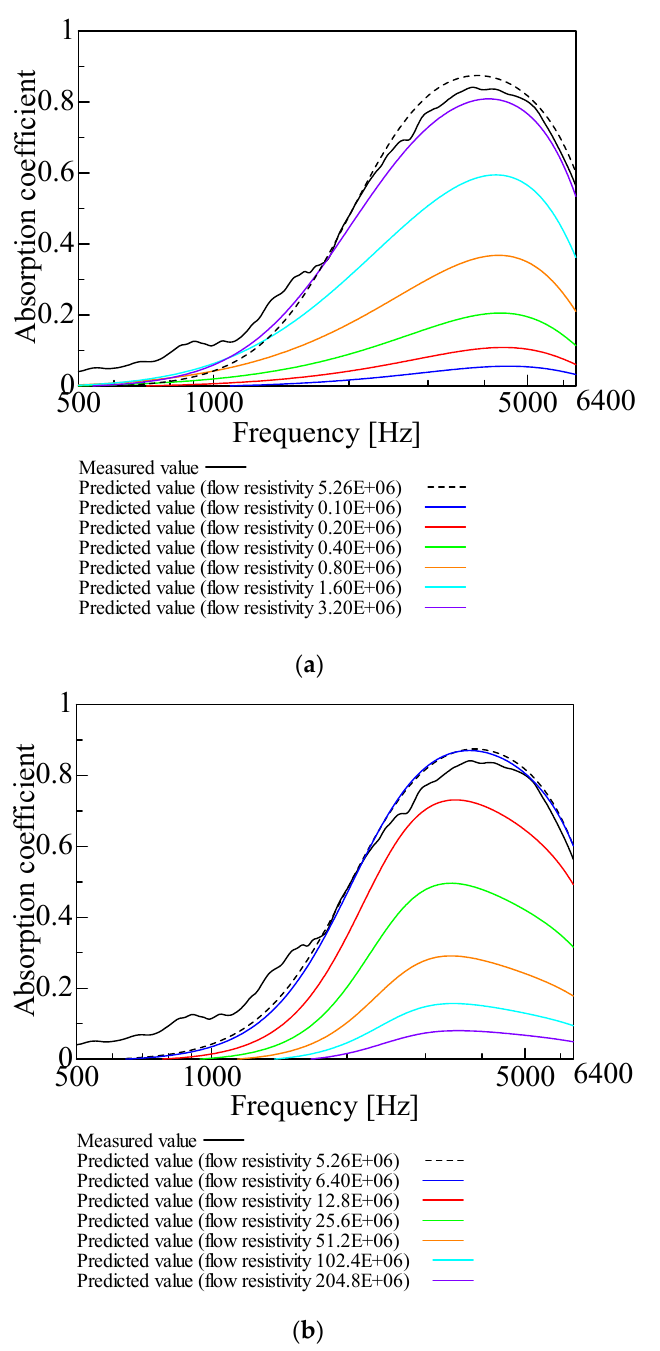
Figure 3. Variation of predicted value due to variation of flow resistivity: ( a ) flow resistivity 0.10 × 10 6 –3.20 × 10 6 and 5.26 × 10 6 ; ( b ) flow resistivity 6.40 × 10 6 –204.8 × 10 6 and 5.26 × 10 6 .